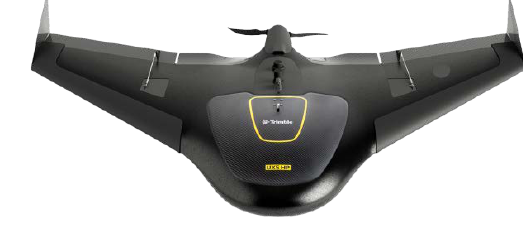
Figure 2: Trimble UX5 HP.